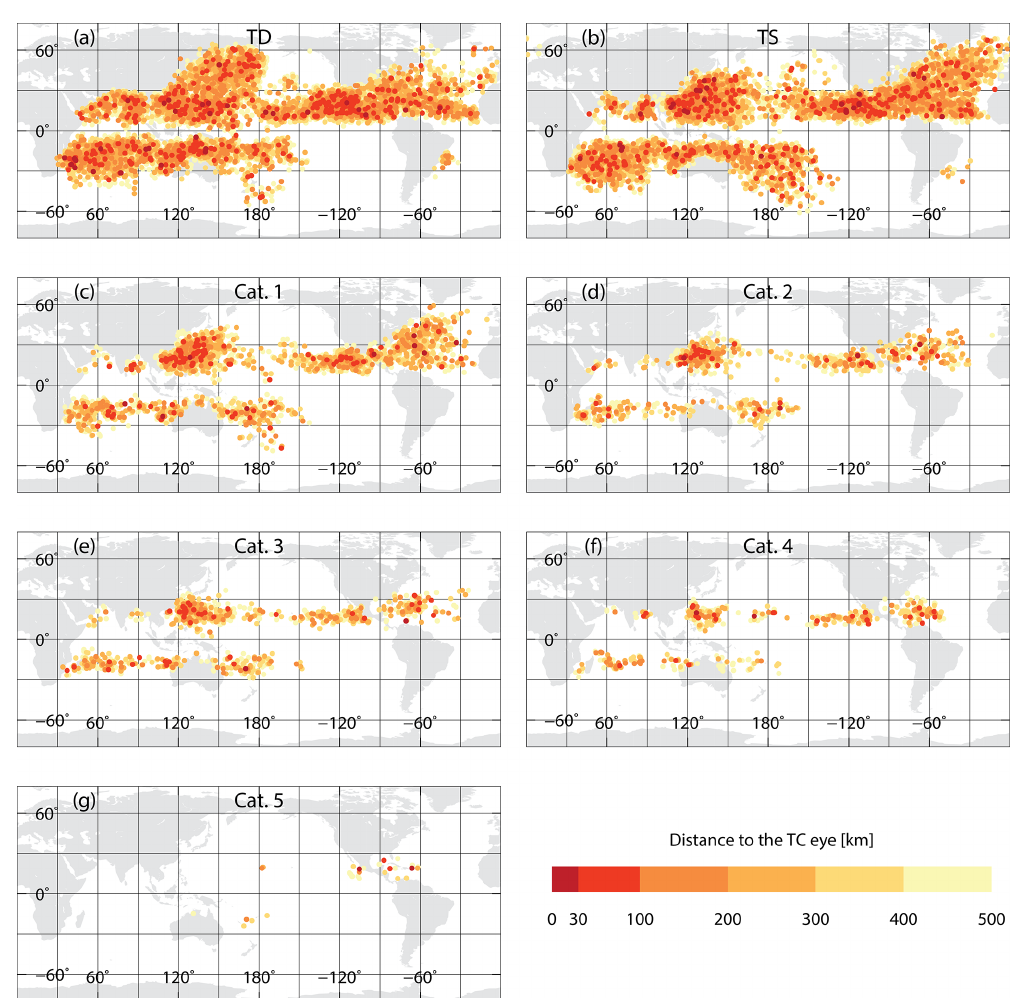
Figure 2. Map with distribution of RO profiles collocated with (a) tropical depressions, (b) tropical storms, (c) Category 1 TCs, (d) Category 2 TCs, (e) Category 3 TCs, (f) Category 4 TCs and (g) Category 5 TCs. Colours denote the distances between the RO profile and the nearest TC